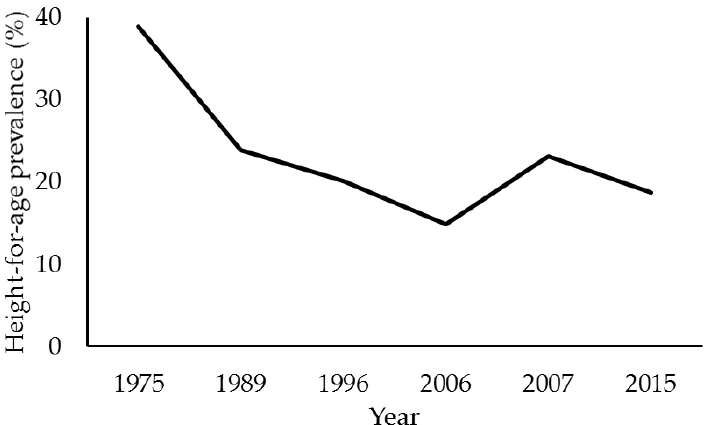
Figure 1. Evolution of height-for-age prevalence (%) in children in Northern Brazil from 1975–2015. Source: National surveys of anthropometry and food consumption [7–11] and SISVAN/Web [15]